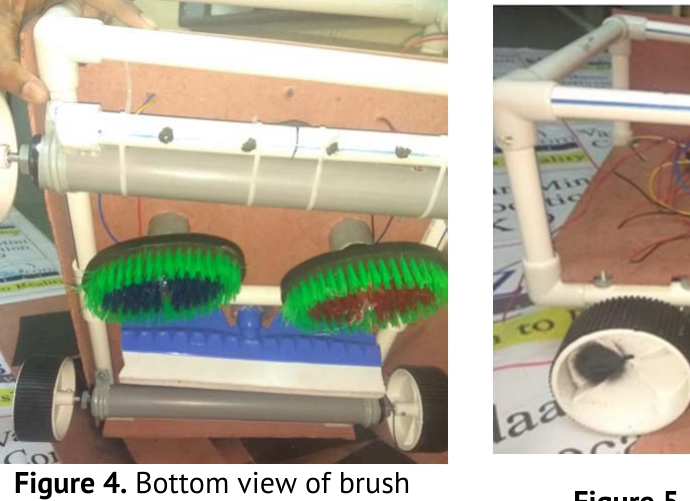
Figure 5. Skeleton of proposed model.